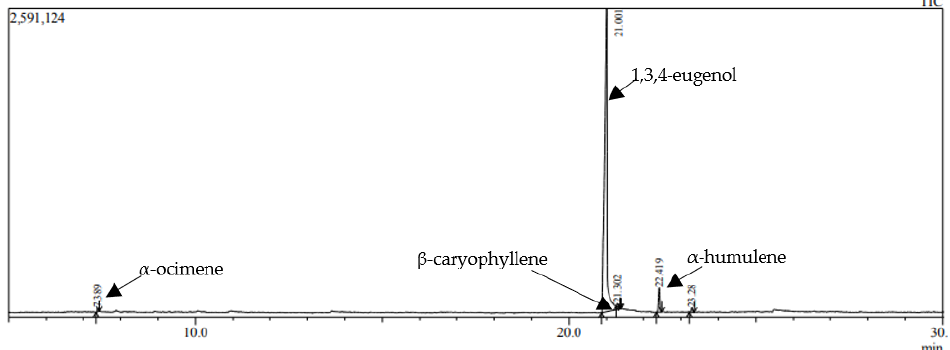
Figure 18. A GC-MS chromatogram of the cinnamon leaf essential oil.